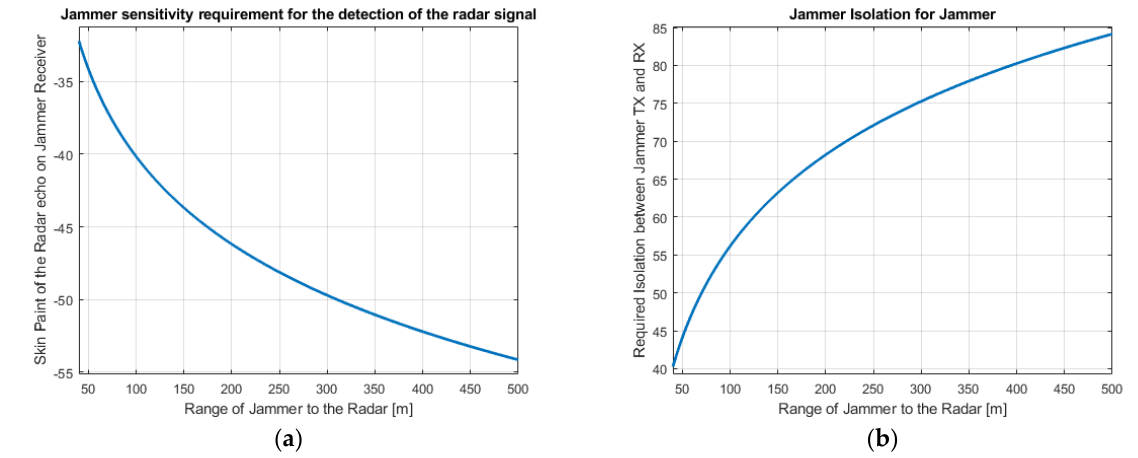
Figure 12. ( a ) The skin paint of the radar signal; ( b ) Required isolation level between the Rx and Tx of the jammer.